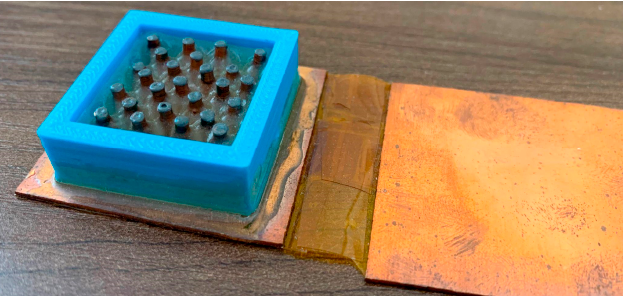
Figure 6. PCM combined with heat pipes for thermal energy absorption [54].